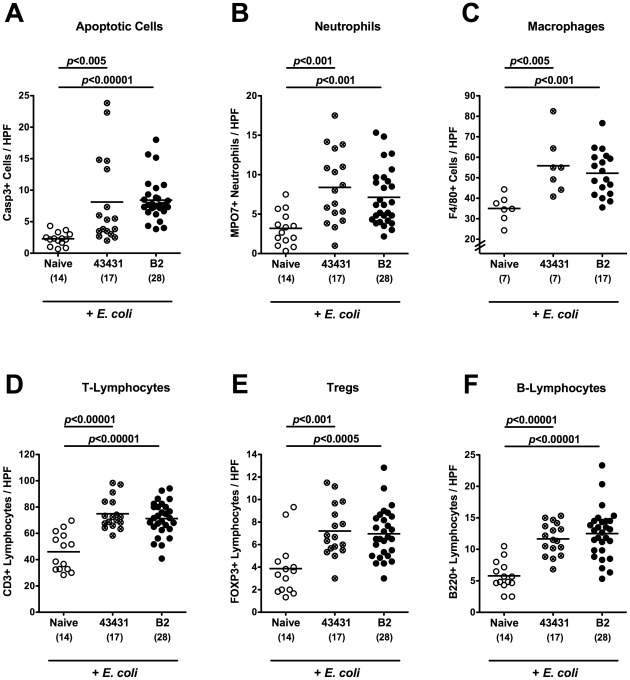
Immune responses following C. jejuni infection of adult mice with increased E. coli loads.In conventionally colonized 3-months-old adult mice intestinal E. coli loads were raised up to 108 bacteria per gram feces by adding live E. coli into the drinking water (+ E. coli) as described in Methods. Then, mice were orally infected with C. jejuni strain ATCC 43431 (crossed circles) or B2 (solid circles). The average numbers of apoptotic cells (positive for caspase-3, panel A), neutrophilic granulocytes (Neutrophils, positive for MPO-7, panel B), macrophages (positive for F4/80, panel C), T-lymphocytes (positive for CD3, panel D), regulatory T-cells (Tregs, positive for FOXP3, panel E) and B-lymphocytes (positive for B220, panel F) from at least six high power fields (HPF, 400×magnification) per animal were determined microscopically in immunohistochemically stained colon sections at day 12 p.i. Uninfected mice (Naïve, open circles) served as negative controls. Numbers of analyzed animals are given in parentheses. Means (black bars) and levels of significance (P-values) as compared to uninfected (Naïve) control mice (determined by the Student’s t-test) are indicated. Data shown are pooled from at least three independent experiments.